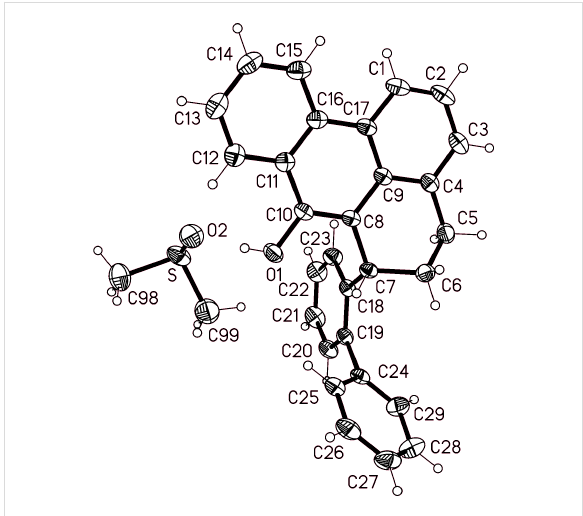
Figure 6: Ellipsoid representation (50% level) of compound 13 (d 6 - DMSO solvate) in the crystal. Hydrogen bonds (see text) are not drawn explicitly.